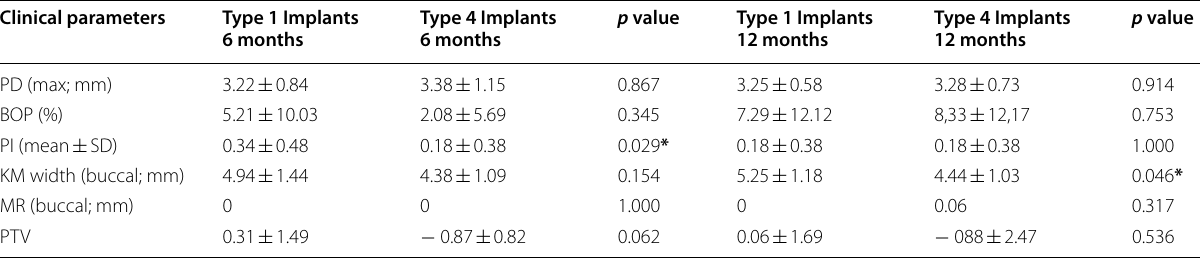
SD) at 6- and 12-month follow-ups, at the implant level ( n ±